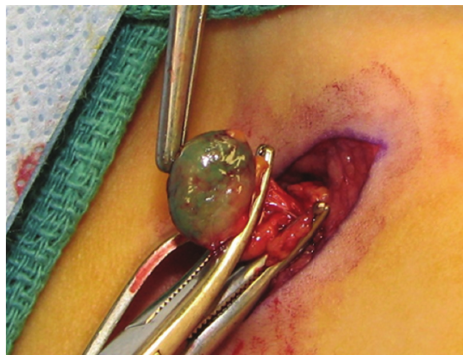
Figure 2: One of the “blue/hot” lymph nodes being removed from the right axilla.